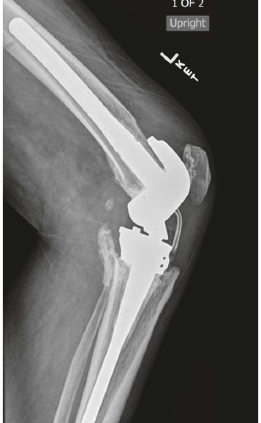
Figure 1: Note retained drain deep to patellar